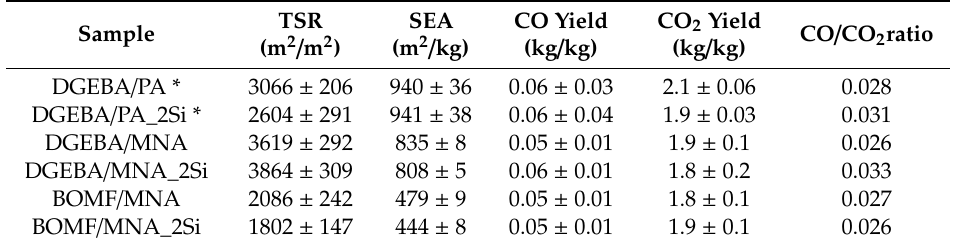
Table 5. Smoke results from cone calorimetry tests performed on epoxy resins and epoxy / silica hybrids. TSR, total smoke release; SEA, specific extinction